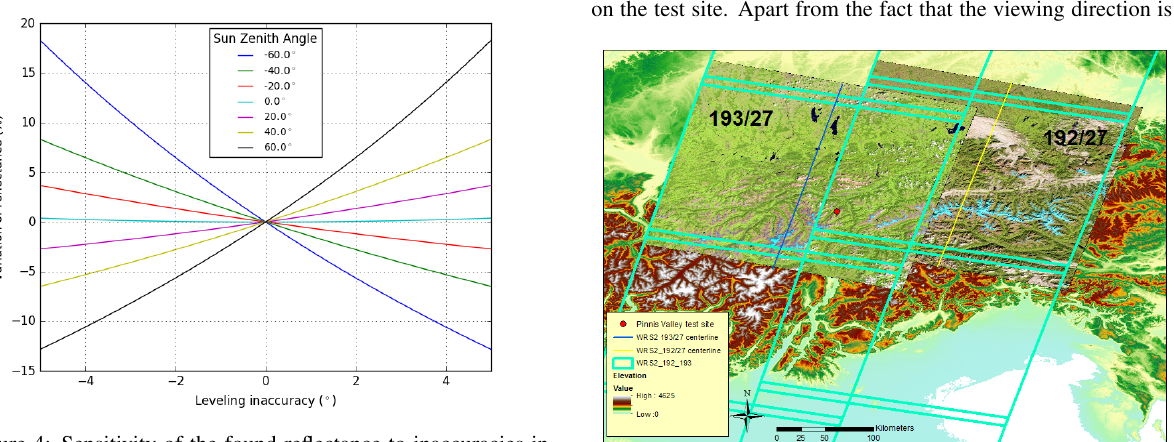
Figure 4: Sensitivity of the found reflectance to inaccuracies in leveling of the field spectrometer. Positive leveling inaccuracies mean a clockwise rotation of the field spectrometer when its front is positioned towards the sun, negative values indicate a counter- clockwise rotation.